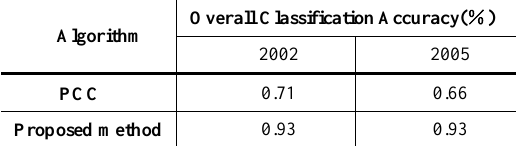
Table 5 . Accuracies of the classification maps at each time by pcc and proposed algorithm